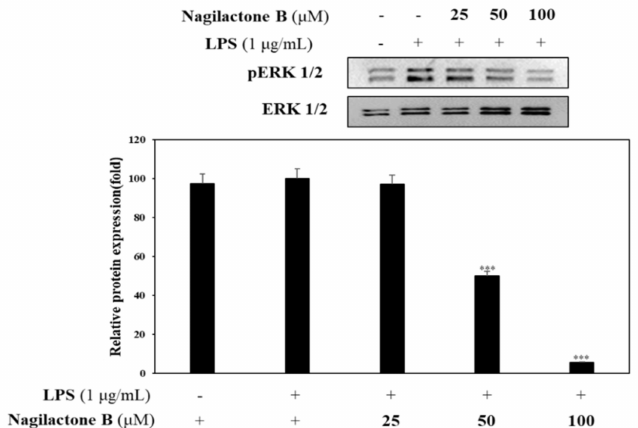
Figure 6. Effect of nagilactone B on pERK 1/2 expression. RAW 264.7 cells were cultured in the presence of compounds (25, 50, and 100 µ M) for 1 h and stimulated with LPS (1 µ g/mL) for 16 h. The levels of pERK 1/2 were detected by western blot analysis. The results are representative of three independent experiments. Relative density was calculated as the ratio of the expression levels of each protein with β -actin. *** p < 0.001 vs. LPS-treated group.